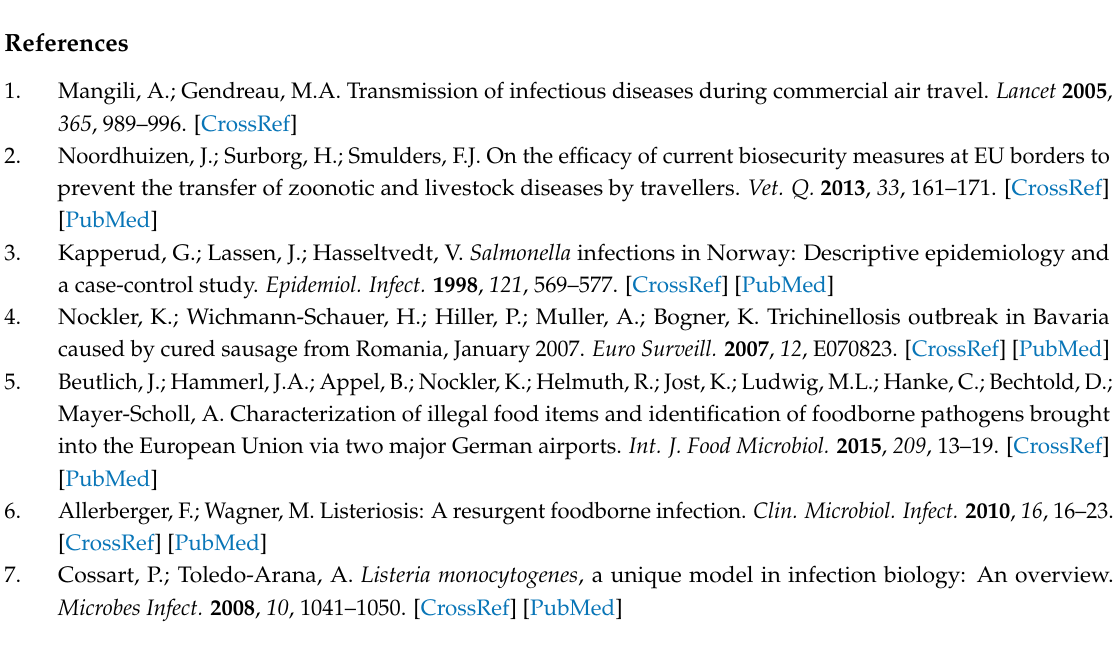
Table S1: Strain characteristics, Table S2: Primers used in this